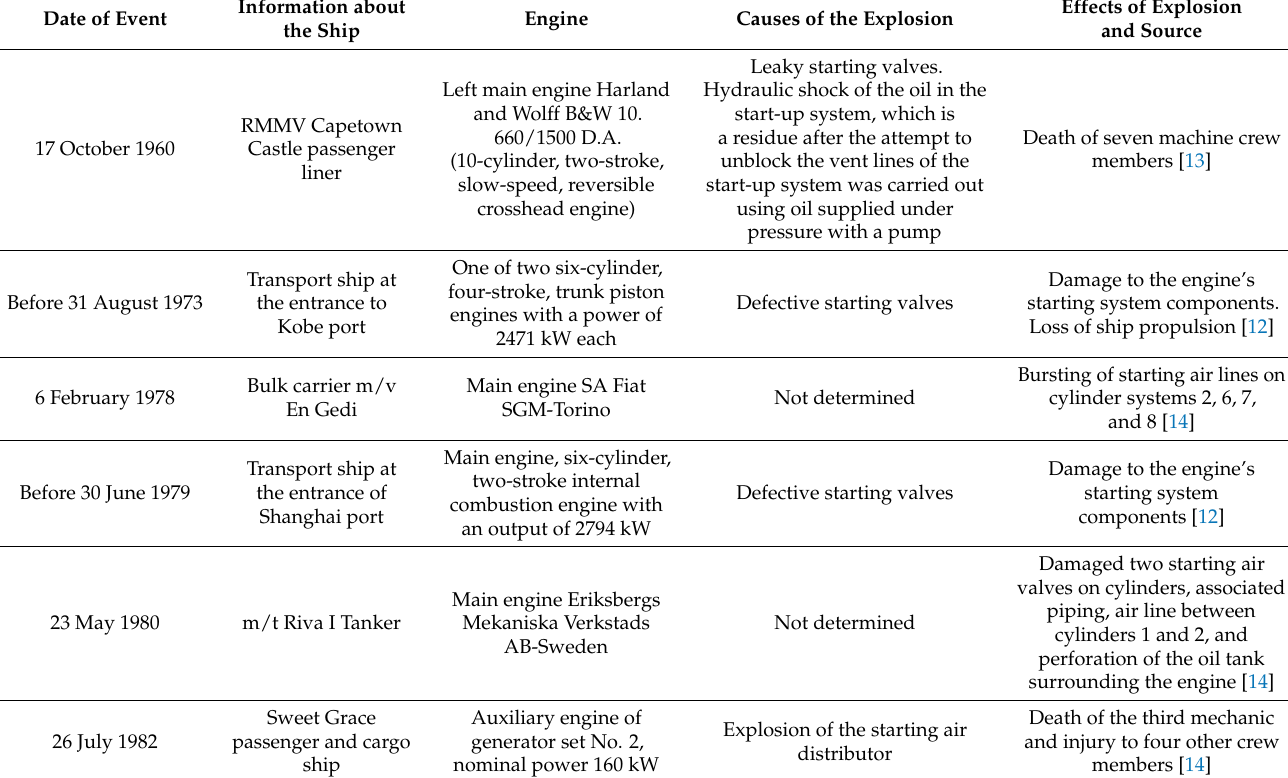
Table A1. Summary of the selected starting air manifold